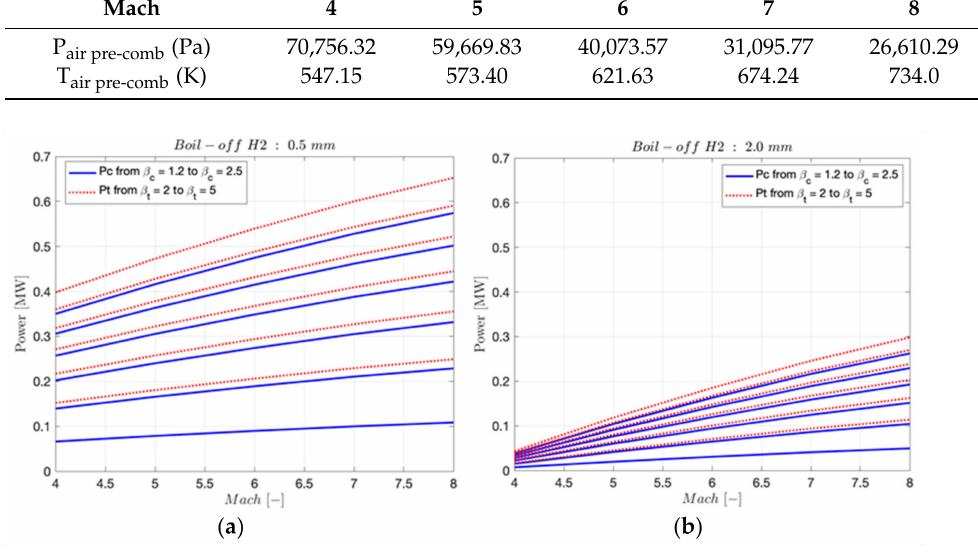
Figure 26. ( a ) Variation of the available (turbine) vs. required (compressor) power of the CAU with Mach number for a 0.5 mm thick boil-off hydrogen insulation layer; ( b ) variation of the available (turbine) vs. required (compressor) power of the CAU with Mach number for 2 mm thick boil-off hydrogen insulation